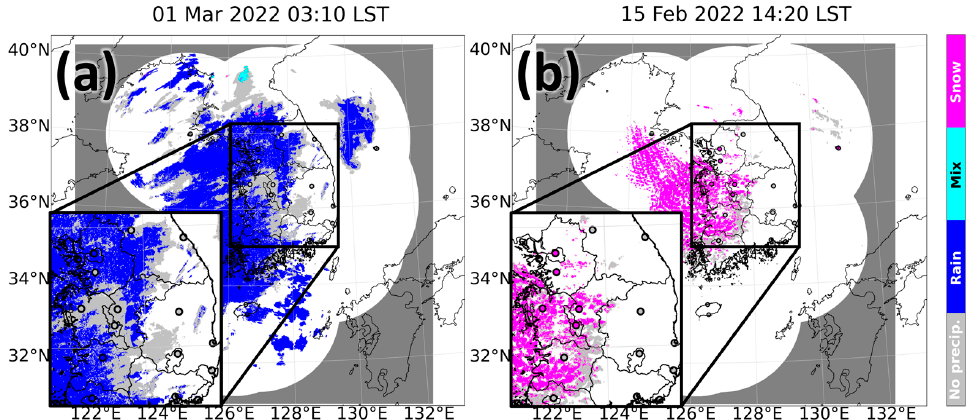
Figure 9. Examples of RF classification in ( a ) rain-dominant case (0310 LST, 1 March 2022) and ( b ) snow-dominant (1420 LST, 15 February 2022). The circle filled with color indicates the ground truth. The insets in ( a , b ) are zoom-in-boxes, providing a clear view of the classification.